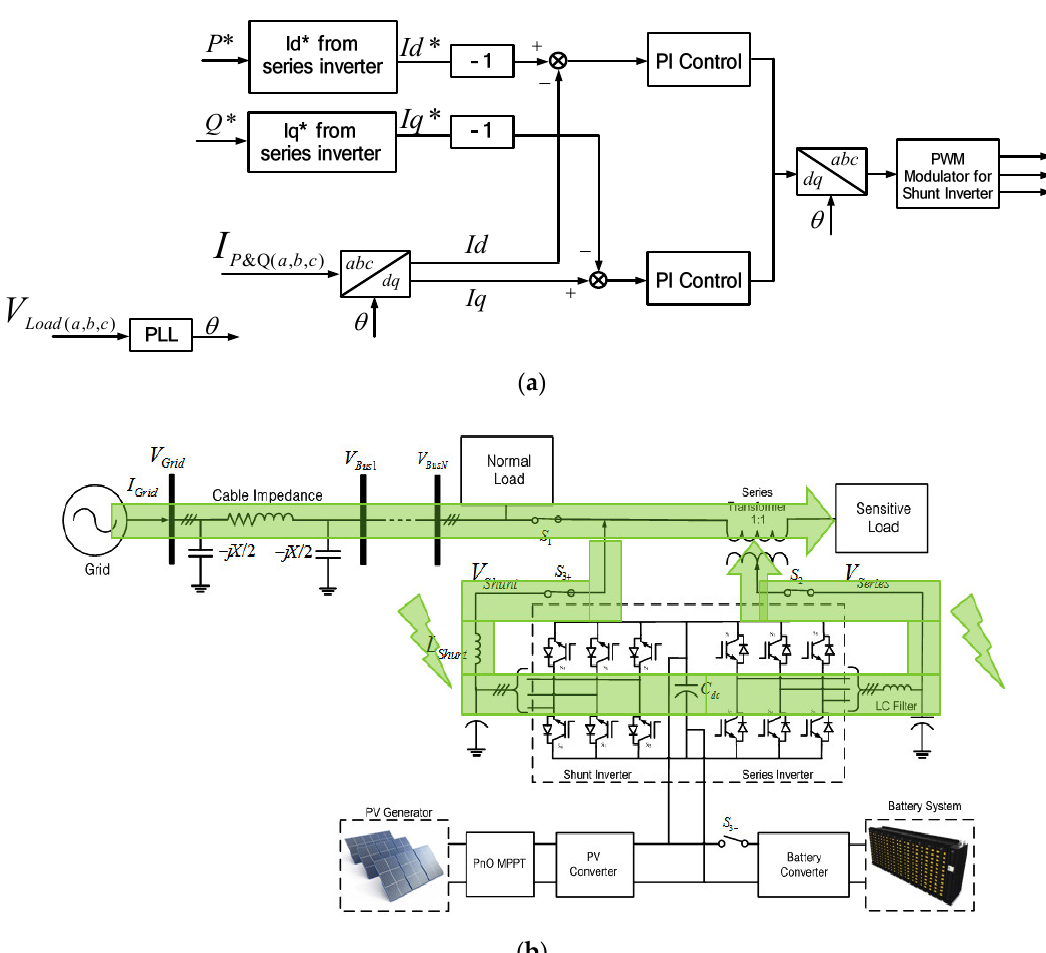
Figure 10. Voltage compensation mode from grid: ( a ) Control scheme; ( b ) power flow condition.